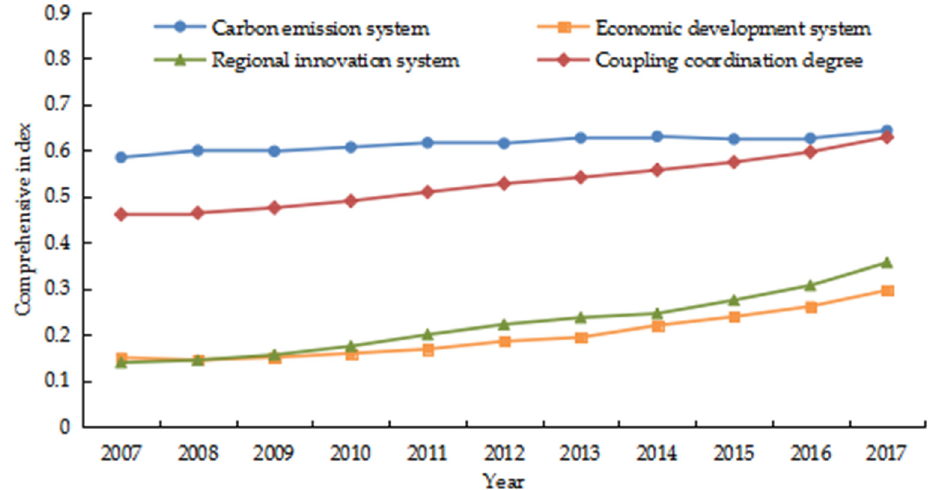
Figure 2. The spatiotemporal evolution of the coupling coordination degree.